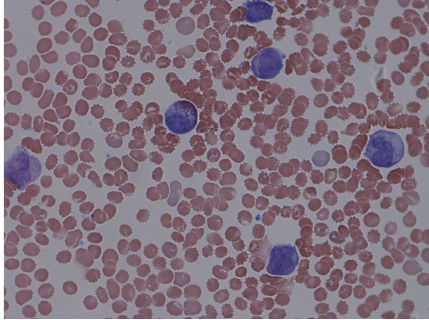
Figure 2: The patient’s peripheral blood smear revealed promyelo- cytes containing Auer rods, which is consistent with